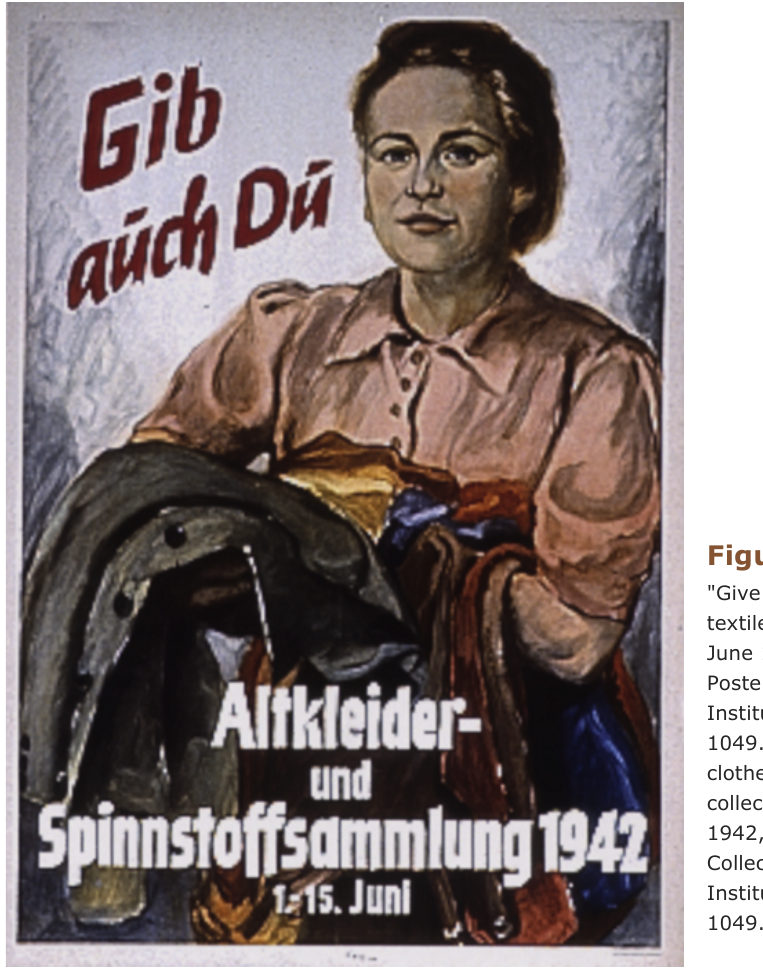
"Give to the old clothes and textile collection drive, June 1-15, 1942,"